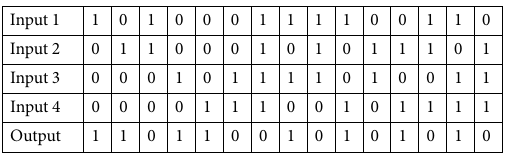
Table 1. Input-output relations to be learned by the